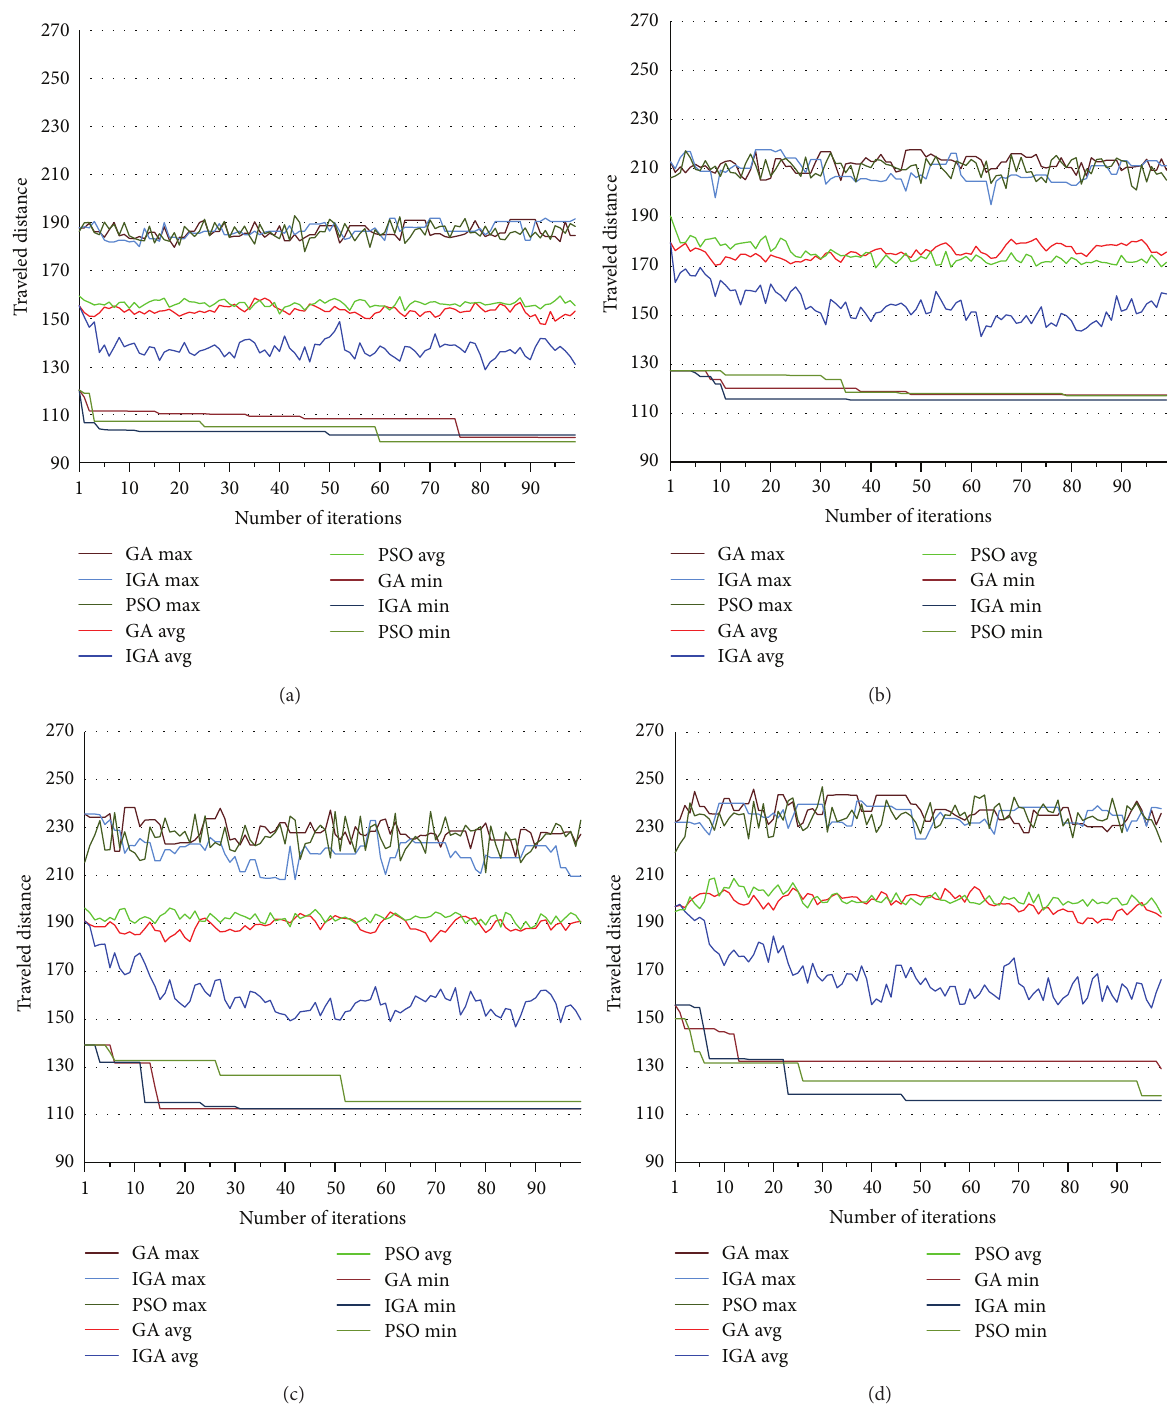
Figure 7: The shortest traveled distance for simulation results for Case 1. All the goods do not overlap by GA, IGA, and PSO. (a) Goods type A, (b) goods type B, (c) goods type C, and (d) goods type D.